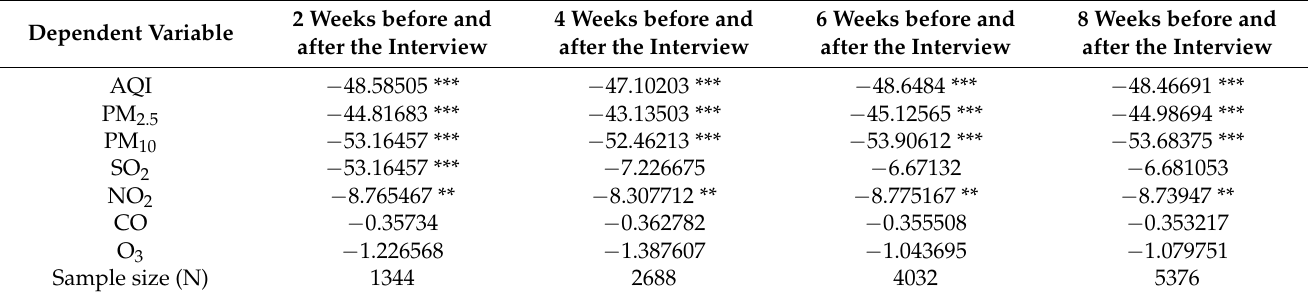
Table 10. Estimated results for different